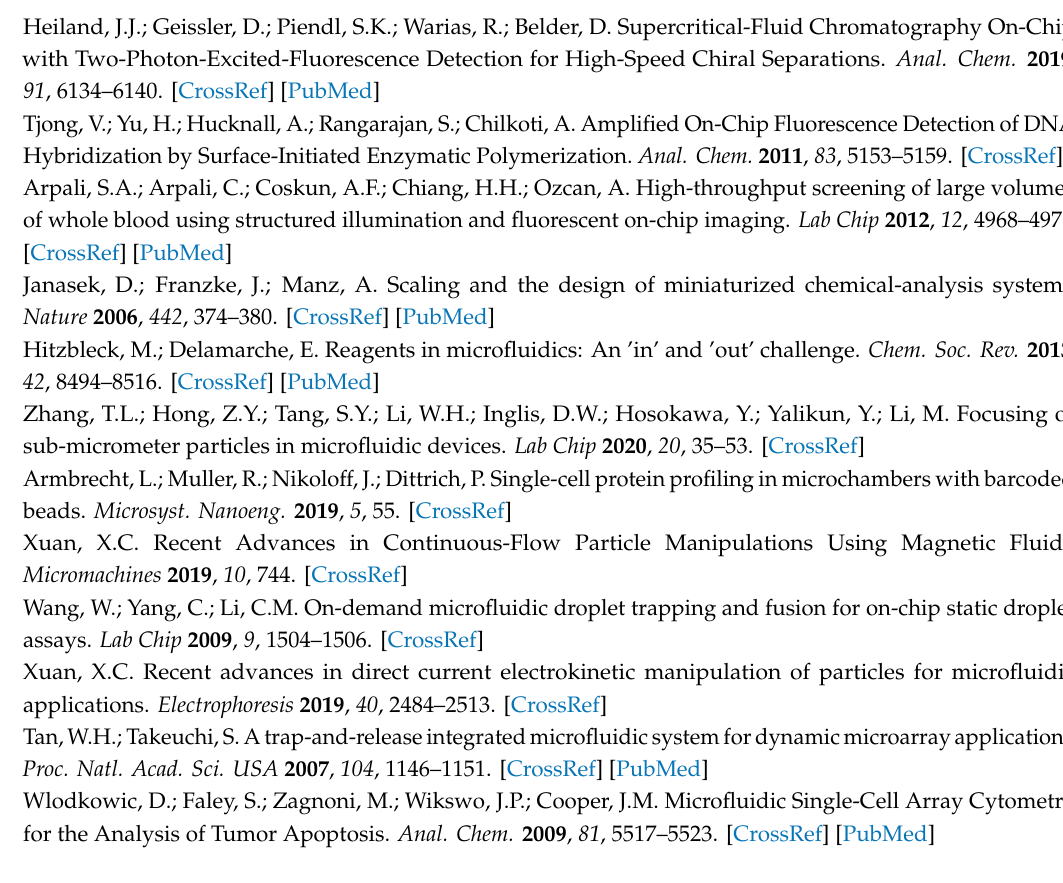
Figure S1 . Optical microscope image of the present droplet generation device; Figure S2 . (a) Optical and fluorescence microscope images of the autofluorescent BSA hydrogel microsphere and (b) dried autofluorescent BSA hydrogel microspheres immobilized in the microchannel. All scale bars are 25 µ m; Figure S3 . pH-dependent fluorescence property of the autofluorescent BSA hydrogel microspheres in the presence of MnO 4 − (80 µ M); Figure S4 . Optical microscope images of the autofluorescent BSA hydrogel microspheres in the presence of MnO 4 − at di ff erent concentrations (pH = 3). All scale bars are 10 µ m; Figure S5 . Microfluidic chip design for immobilizing the autofluorescent BSA hydrogel microspheres loaded with rhodamine B dye (bigger traps) and pure BSA hydrogel microspheres (smaller traps); Video S1 . Droplet generation; Video S2 . Trapping process; Video S3 . Overview after trapping; Video S4 . Drying process; Video S5 . Overview after drying; Video S6 . Water